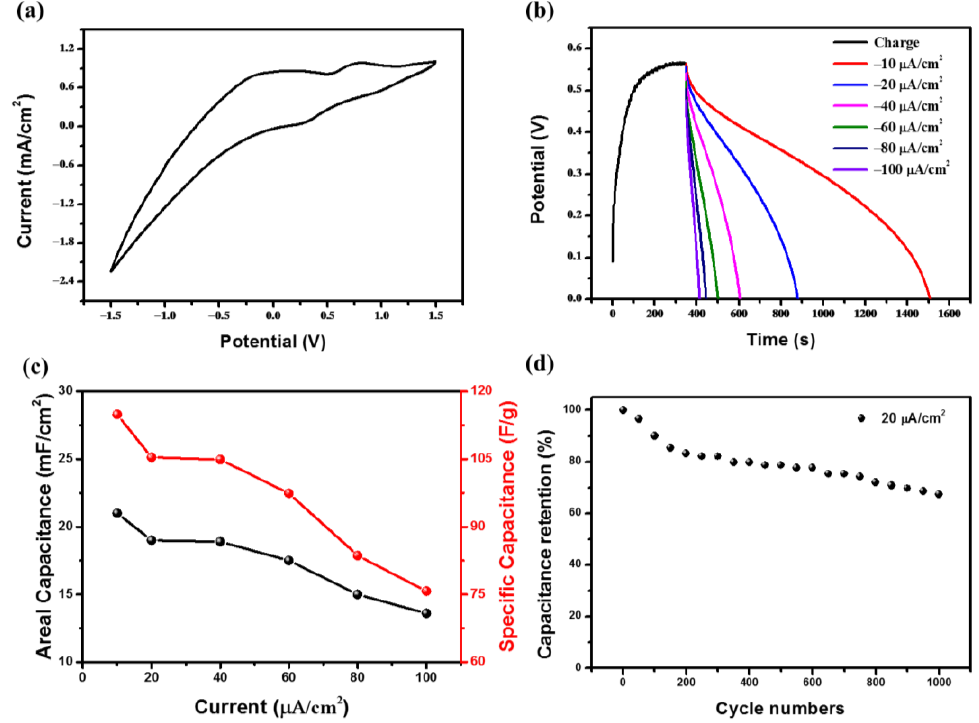
Figure 6. ( a ) The cyclic voltammetry curve of the PECD; ( b ) photo-charge curve and galvanostatic discharge curves of the PECD; ( c ) areal capacitances and specific capacitances of the WO 3 film at different current densities; ( d ) cycle performance of the PECD under a current density of 20 μA/cm 2 .